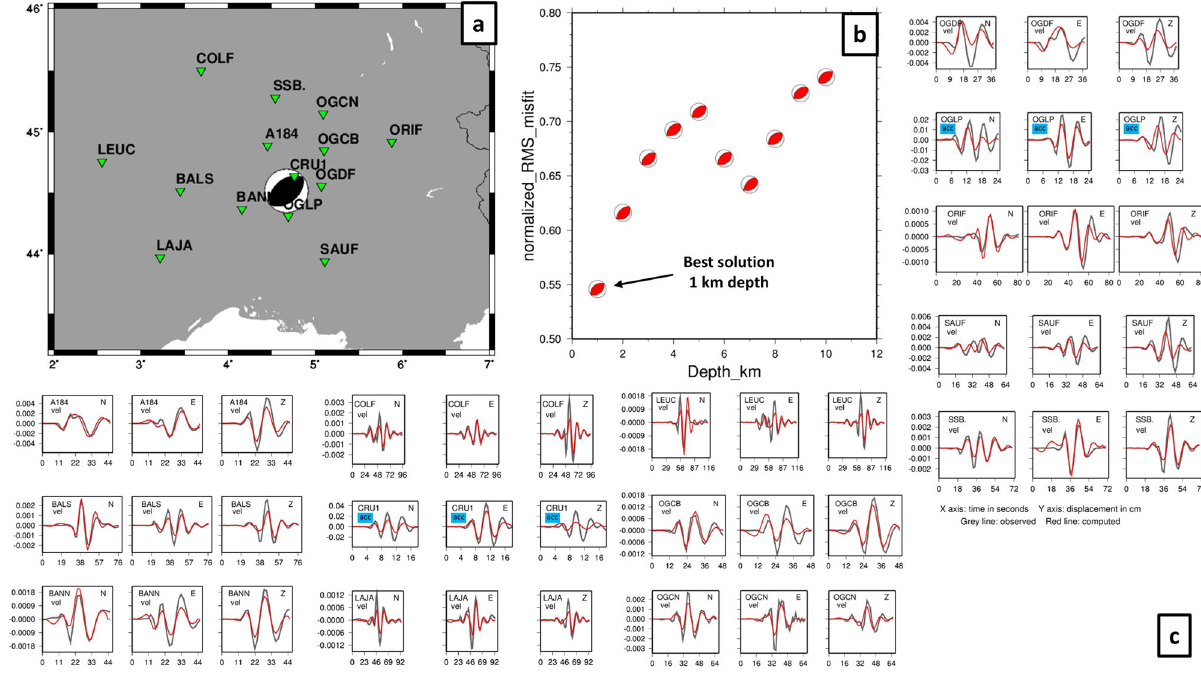
Fig. 2 Result of the waveform inversion. a Map with stations used (green triangles) and the focal mechanism corresponding to the best solution found. b Plot of focal mechanism solutions in an RMS versus depth graph. c Waveform fi t, in displacement (cm) bandpass fi ltered between 0.03 and 0.08 Hz. Observed records are in gray and computed in red. For each station the three components are displayed (N, E, Z), and “ vel ” or “ acc ” (blue labels) means that the original record was in velocity (broadband) or acceleration (strong motion),